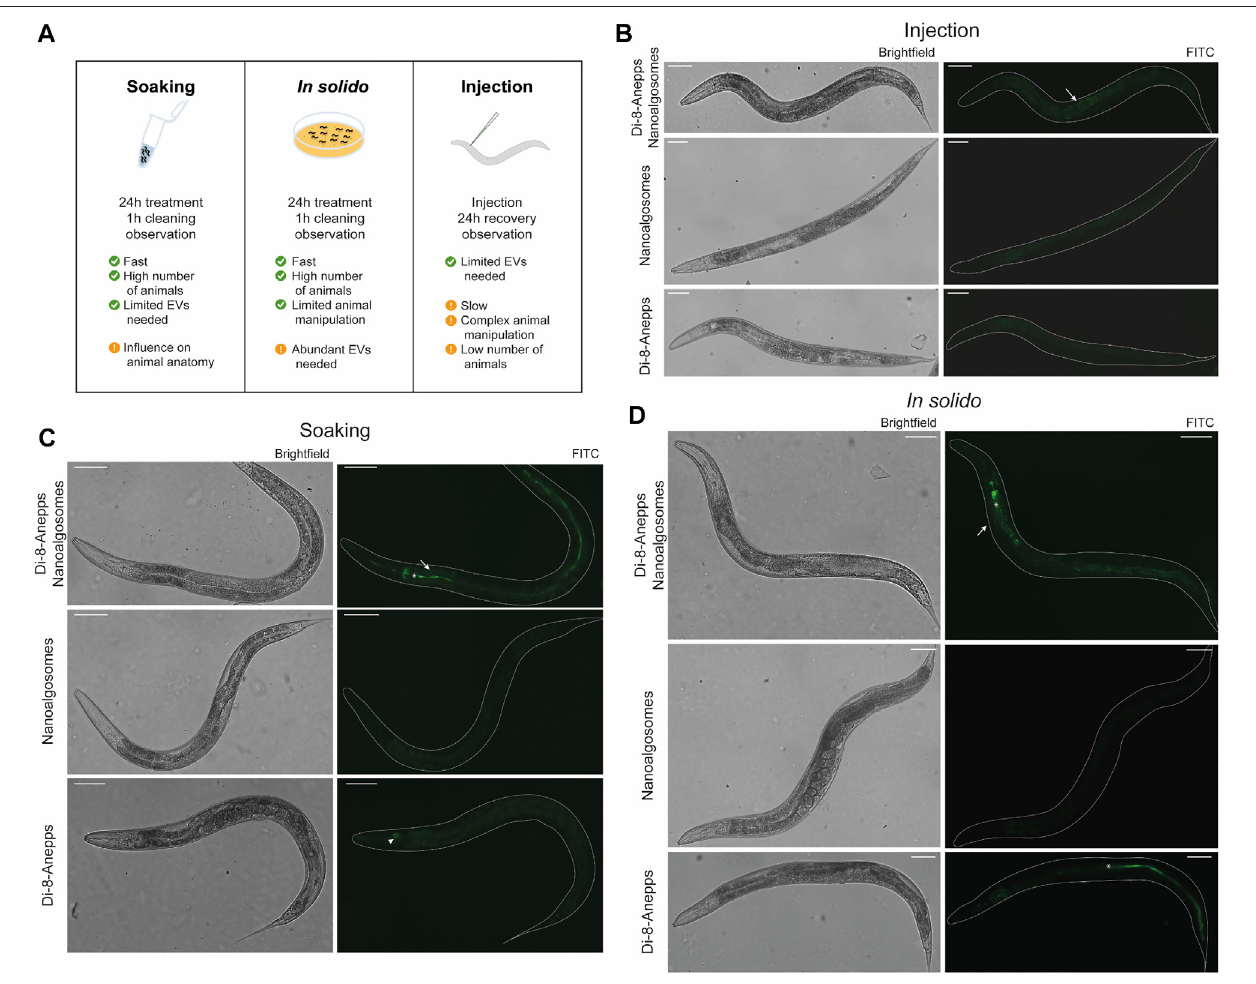
FIGURE 4 | Set-up of labelled nanoalgosomes treatment in C. elegans. (A) Schematic representation of the administration methods used for testing the uptake in C.elegans of fl uorescentnanoalgosomes.Thebestconditionsusedfortreatinganimalsaswellassomeadvantagesanddisadvantagesarelisted. (B – D) Bright fi eld(left) and epi fl uorescence (with FITC fi lter, right) images of animals treated with Di-8-Anepps-nanoalgosomes, nanoalgosomes and free-dye (Di-8-Anepps) by injection (B) , soaking (C) and in solido (D) . A fl uorescent signal was observed in the intestinal cells of the animals treated with labeled nanoalgosomes (arrows). Moreover, aspeci fi c signals were observed in the head after soaking (arrowhead) and in solido with free-dye (asterisks). Anterior is left and ventral is down. Scale bar 75 µm.